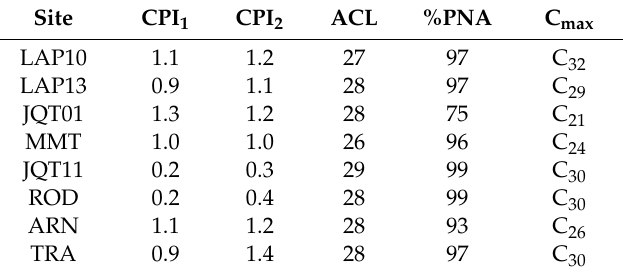
Table 3. Carbon preference index (CPI), average chain length (ACL) values and C max for the n -alkanes at all sites. Site CPI 1 CPI 2 ACL %PNA C max LAP10 1.1